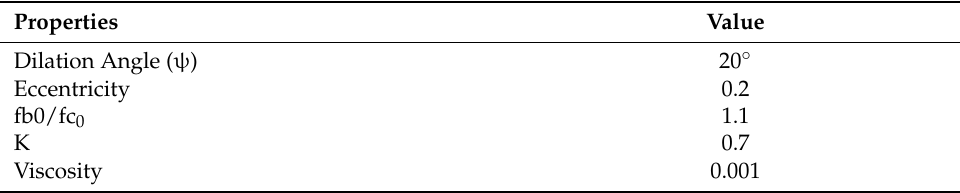
Table 2. Parameters for concrete damage plasticity behaviour of